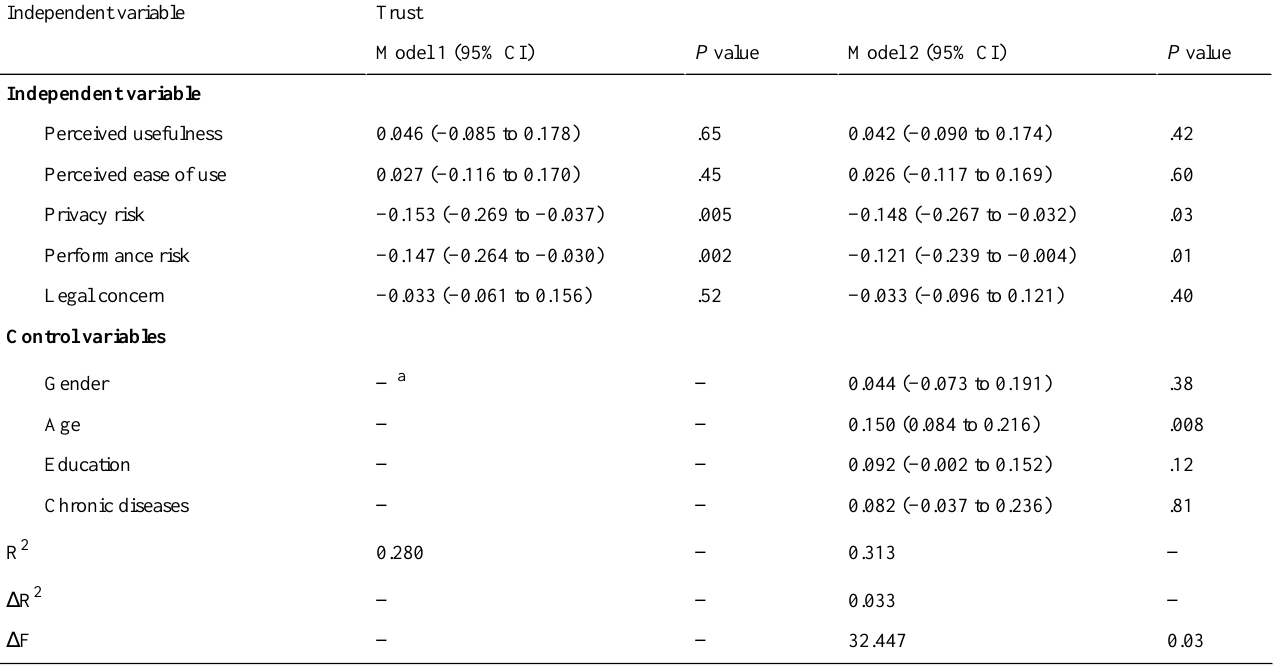
Table 5. Results of multiple linear regression analysis for independent variable Trust. R 2 : coefficient of determination, Δ R 2 : change in the coefficient of determination, Δ F: change in the F-statistic.